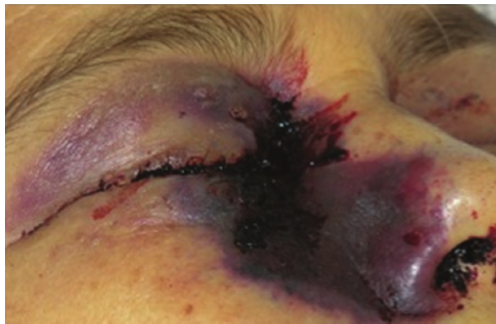
Figure 4: Aspect of patient with periorbital edema and ecchymosis of the surrounding